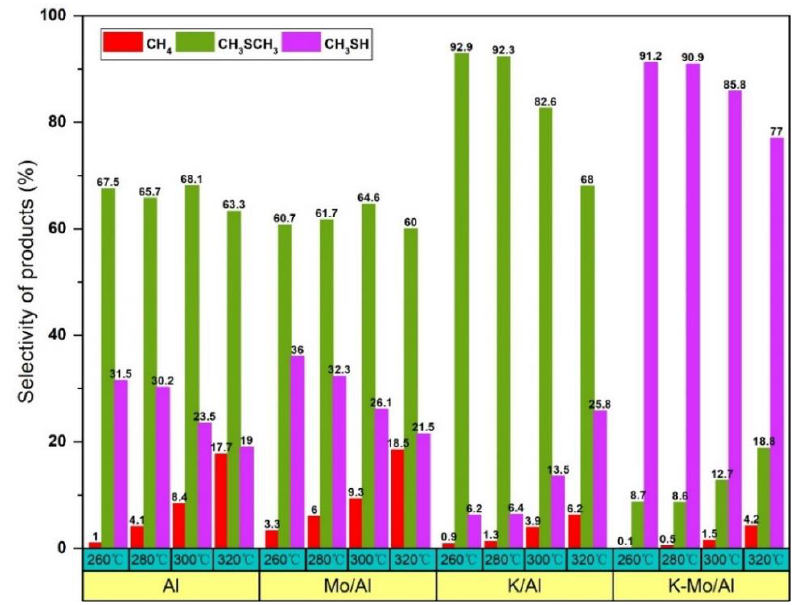
Figure 1. The selectivities toward CH 4 , CH 3 SCH 3 and CH 3 SH as a function of reaction temperature over the Al, Mo/Al, K/Al and K-Mo/Al catalysts. Reaction conditions: p = 0.3 MPa, R(CS 2 ) = 1.6 mL/h, R(H 2 ) = 30 mL/min, 2 mL of the Catalyst.